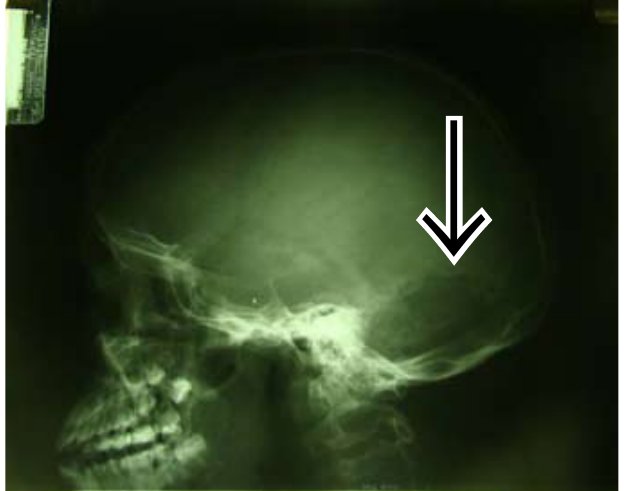
Fig. 2a. Lateral skull X-ray demonstrates defect in the lambdoid suture.